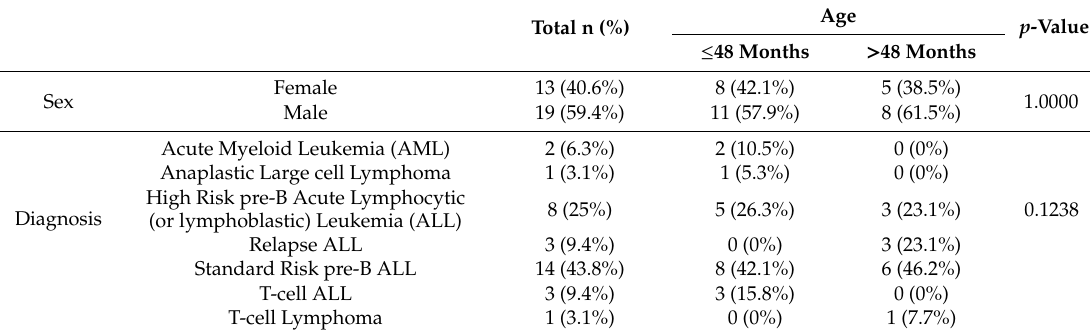
Table 1. Summary of Demographic and Clinical Characteristics of Sample by Age Group.